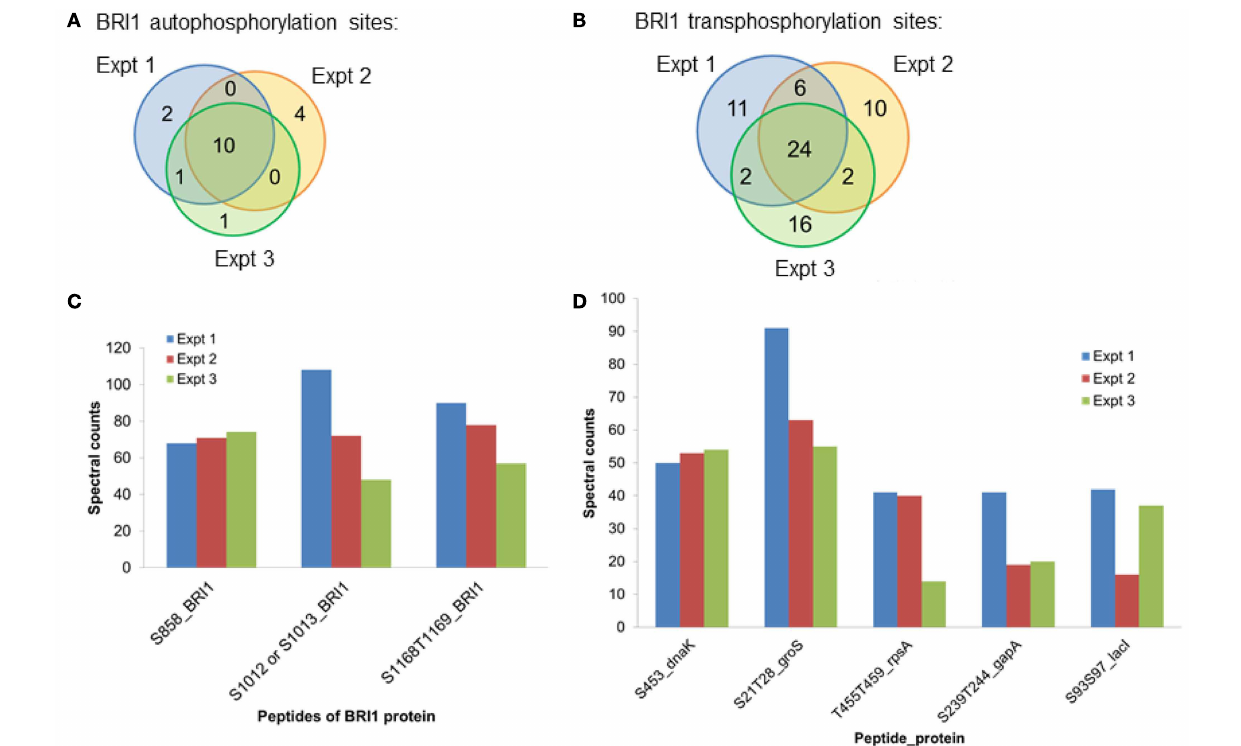
FIGURE 8 |The reproducibility of the proteomics analysis in this study. Three biological replicates of BRI1 auto- and transphosphorylated E. coli cells were digested with trypsin. Phosphopeptides were enriched with theTiO 2 method, before identification with data-dependent analysis in the mass spectrometry. (A) Venn diagram showing the overlap of the identified BRI1 autophosphorylation peptides from three biological replicates.Ten abundant BRI1 autophosphorylation peptides were commonly identified. (B) Venn diagram showing the overlap of the